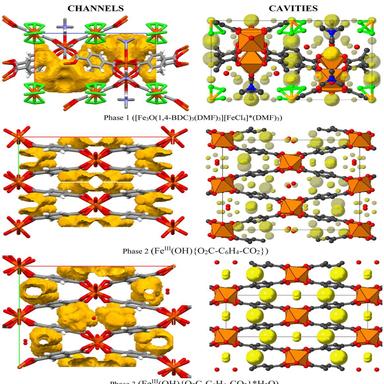
Illustration of the channels for Li+ ion diffusion and cavities for Li+ insertion.